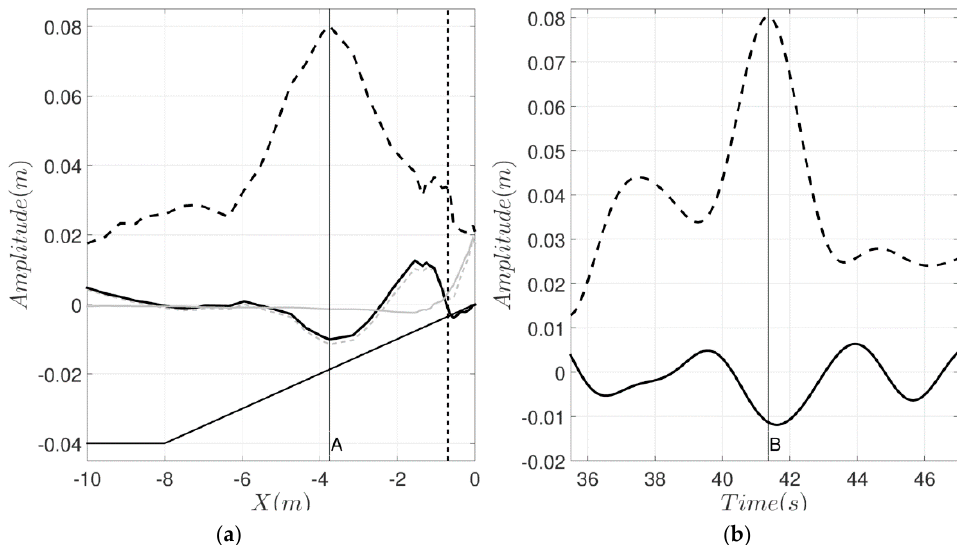
Figure 2. ( a ) Spatial visualization of short wave envelope (dashed black line), total long wave surface elevation (grey dashed), long wave with setup removed (full black line) and mean setup (full grey line), over bottom topography shown (solid black line). ( b ) Time evolution of short wave envelope (dashed line) and total long wave (full line) at x = − 3.75 m (location A in left panel). Random wave case J6033A from Baldock and Huntley [25].